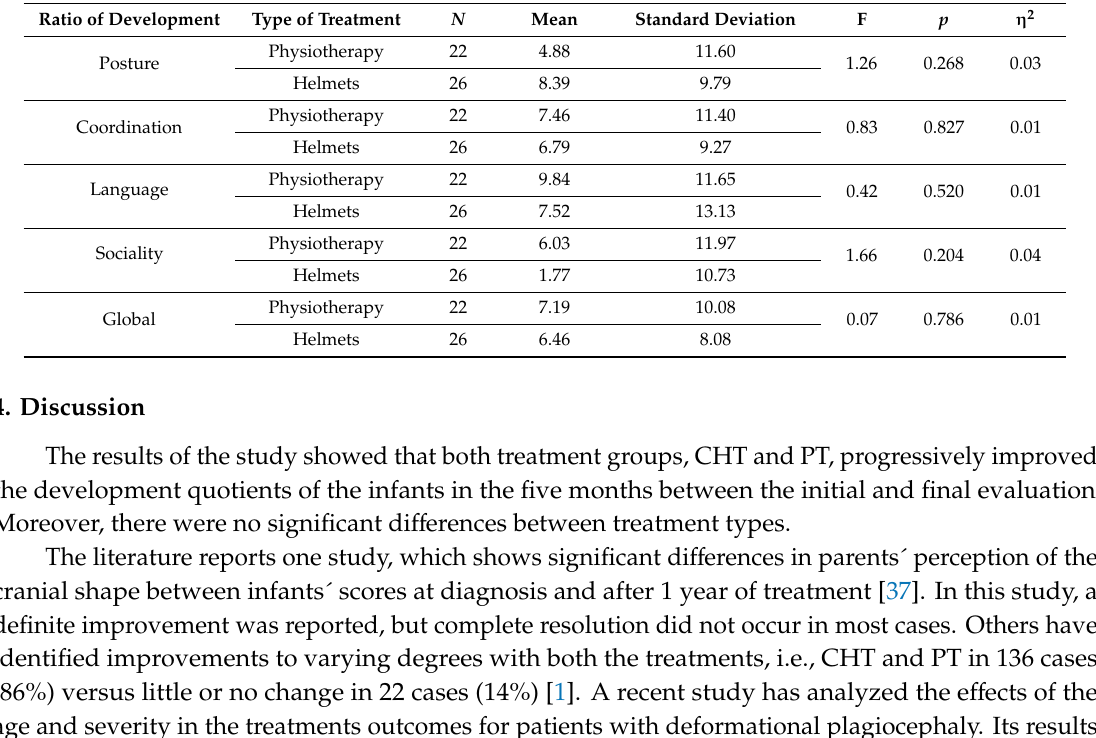
Table 2. Increase in the ratio of development between the initial and final assessment of each treatment group, assessment by the Brunet–Lezine